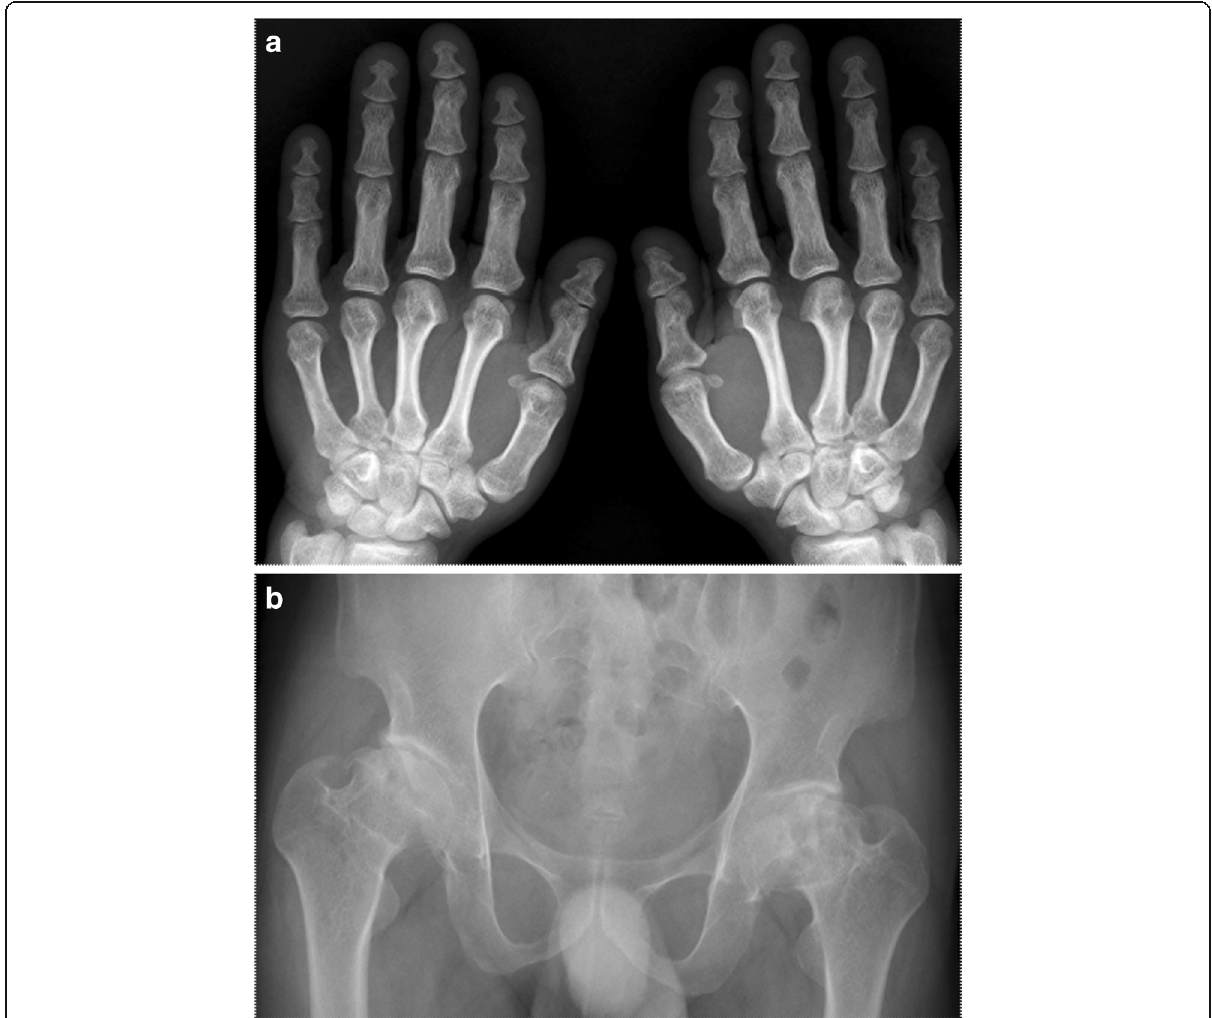
Fig. 2 a : Short bone deformity of both hands. b : Bilateral avascular necrosis of the femoral